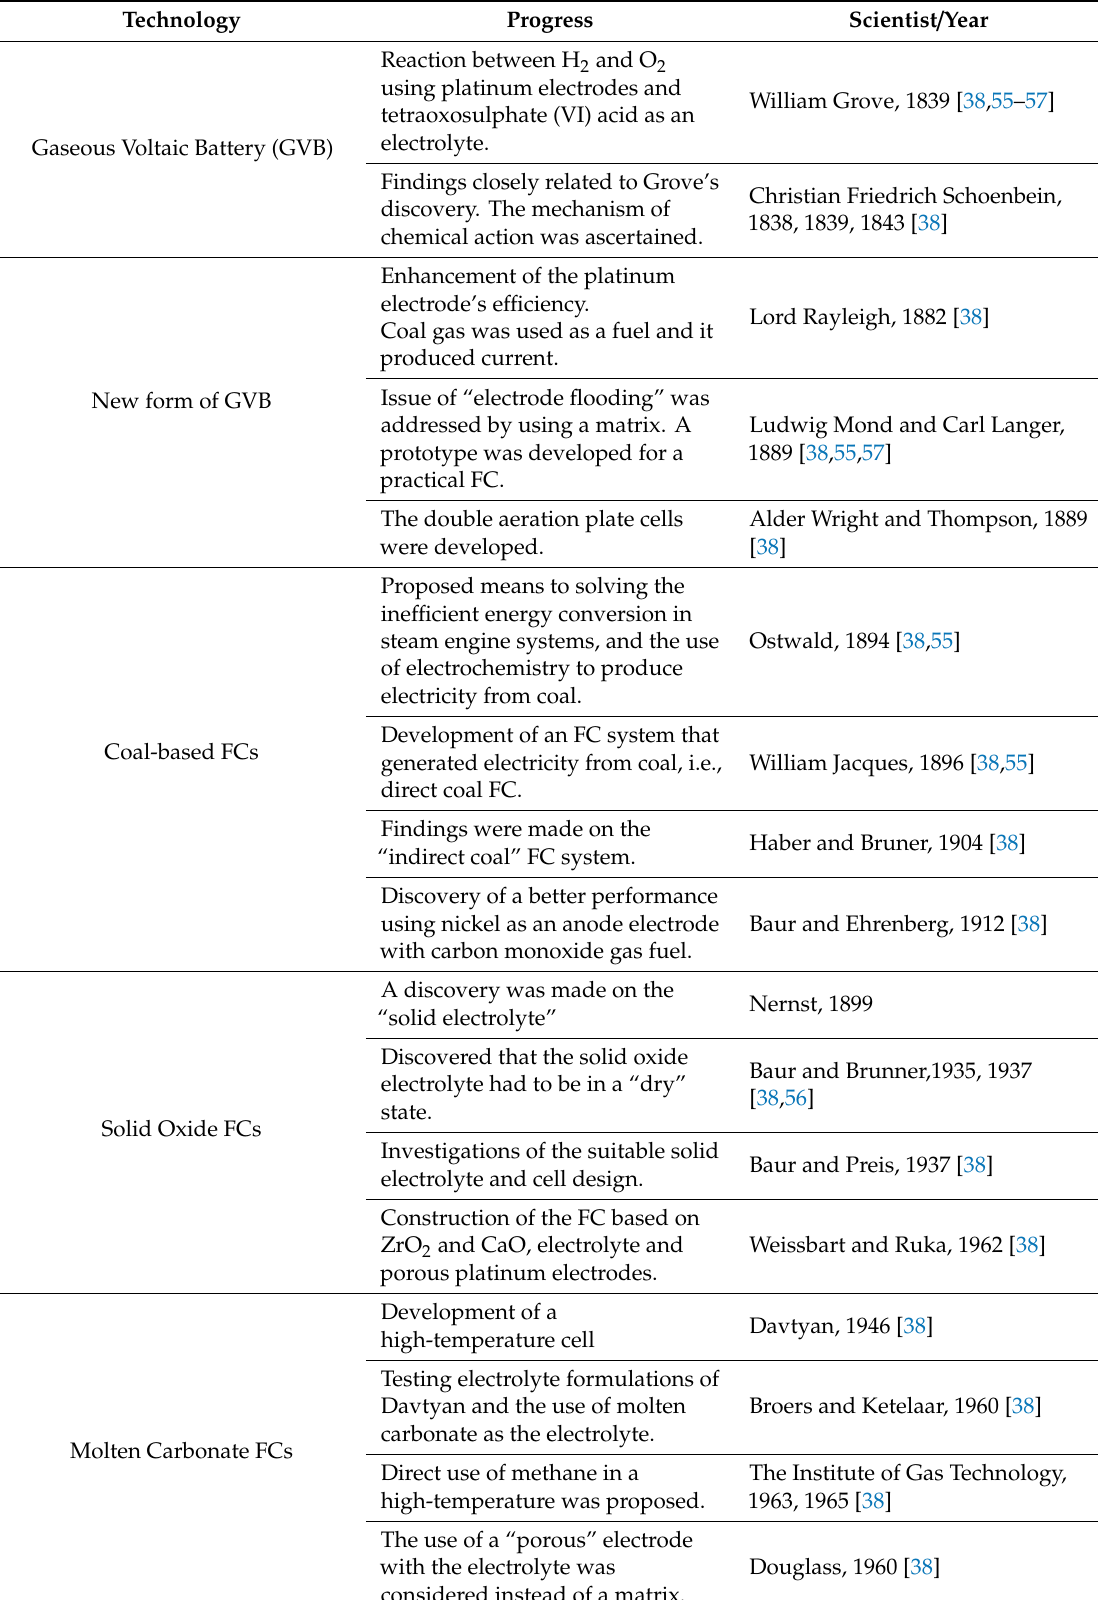
Table 1. History of stationary FC